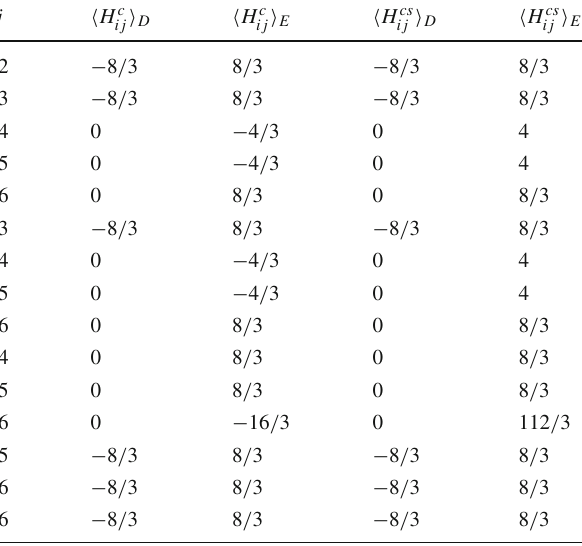
Table 9 The cross matrix elements in spin-flavor-color-isospin spaces of the color-singlet and hidden-color channels for the Ω ccc Ω ccc